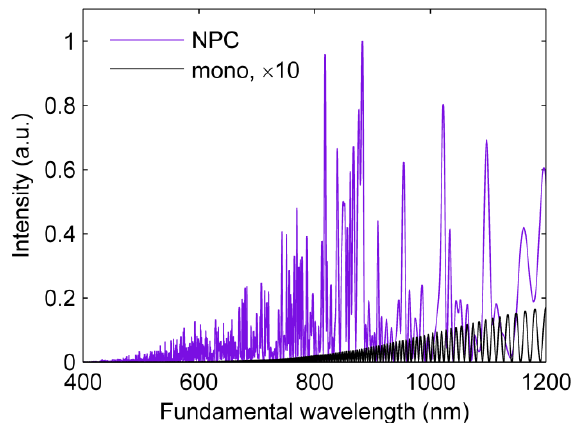
Figure 4. Spectral dependence of the second harmonic for a sample of NPC SBO (blue) and single domain sample (black) calculated by varying the fundamental wavelength. Real domain structure of NPC SBO mapped via optical microscopy was used in the